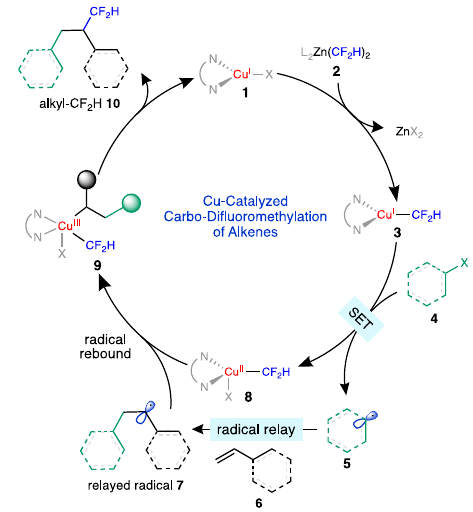
Fig. 2 Proposed catalytic cycle for the copper-catalyzed carbo- di fl uoromethylation of alkenes. The proposed mechanism involves the single electron transfer (SET) from a [Cu-CF 2 H] species to an electrophile to form a carbon-centered radical, which reacts with an alkene to afford a relayed radical. The relayed radical reacts with a [Cu II -CF 2 H] species to form the di fl uoromethylated